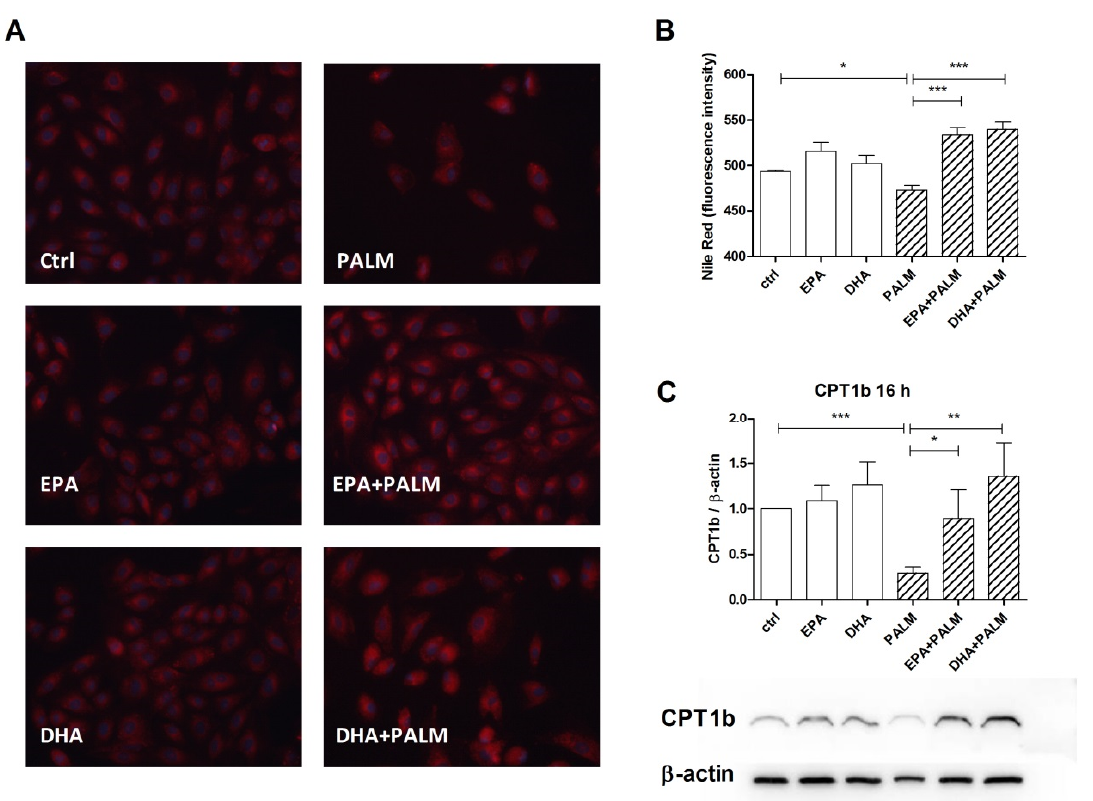
Figure 4. E ff ect of n-3 PUFAs on the accumulation of neutral lipids and the expression of CPT1b protein in H9c2 cells exposed to palmitate. H9c2 cells were incubated in the presence or absence of fatty acids as described in the legend of Figure 1. After a 16 h incubation, H9c2 cells were analyzed for the content of neutral lipids by Nile red staining or for CPT1b protein content. ( A ) Representative microscopy fields of cells stained with Nile red. Scale bar corresponds to 50 µ m. ( B ) Quantitative analysis of Nile Red fluorescence by flow cytometry. ( C ) Relative quantification for CPT1b / β -actin ratio by western blot. Panel C, bottom, shows a representative blot image for CPT1b and β -actin. Di ff erences are indicated with *, **, *** for p < 0.05, p < 0.01 and p < 0.001, respectively.